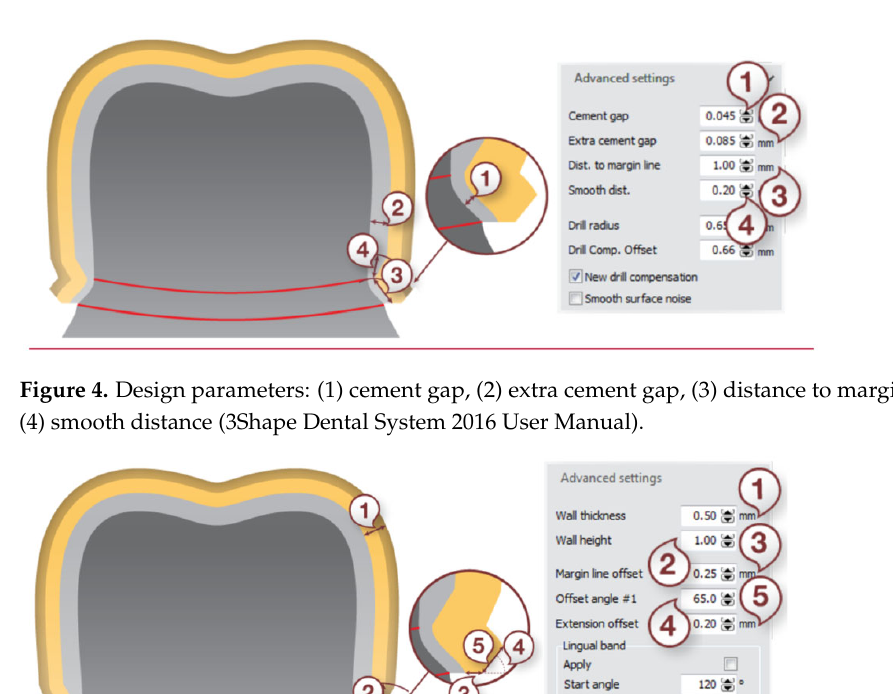
Figure 3. Abutment scanning and substructure design in the 3Shape Dental System clinical system.